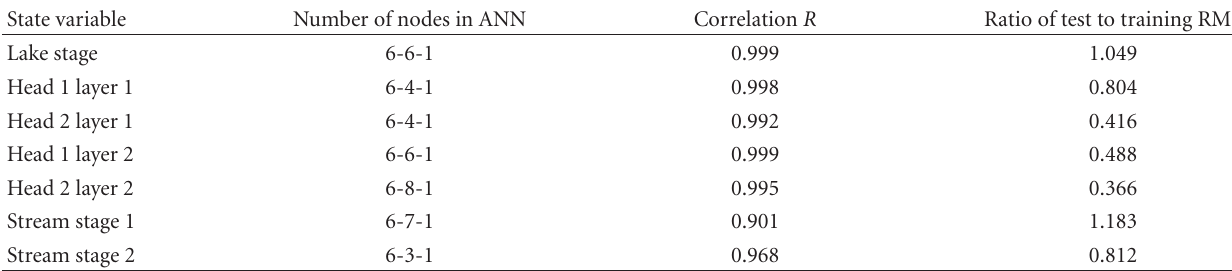
Table 3: Evaluation results for 7 ANNs in stress period 1.